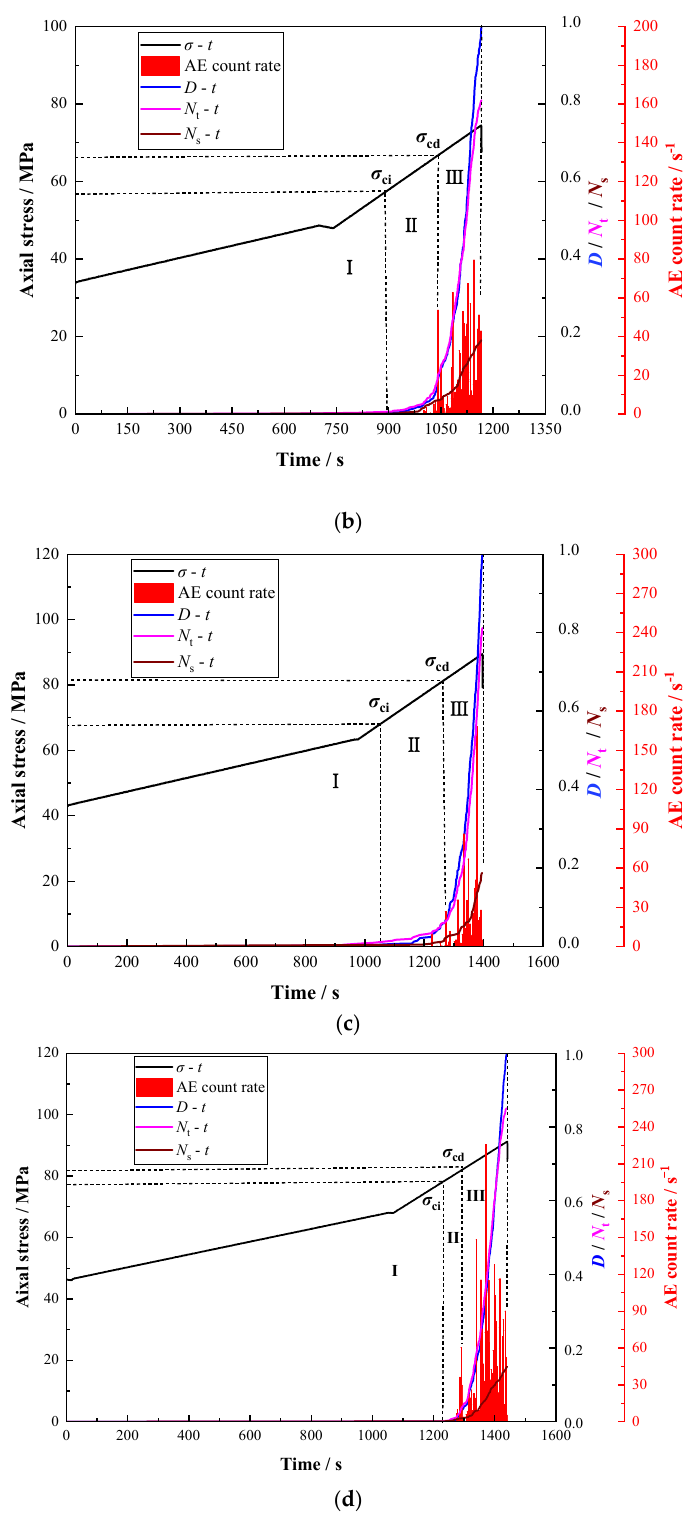
Figure 13. Crack propagation and damage evolution of coal samples at different depths under triaxial unloading: ( a ) 300 m, ( b ) 600 m, ( c ) 850 m, and ( d ) 1050 m.